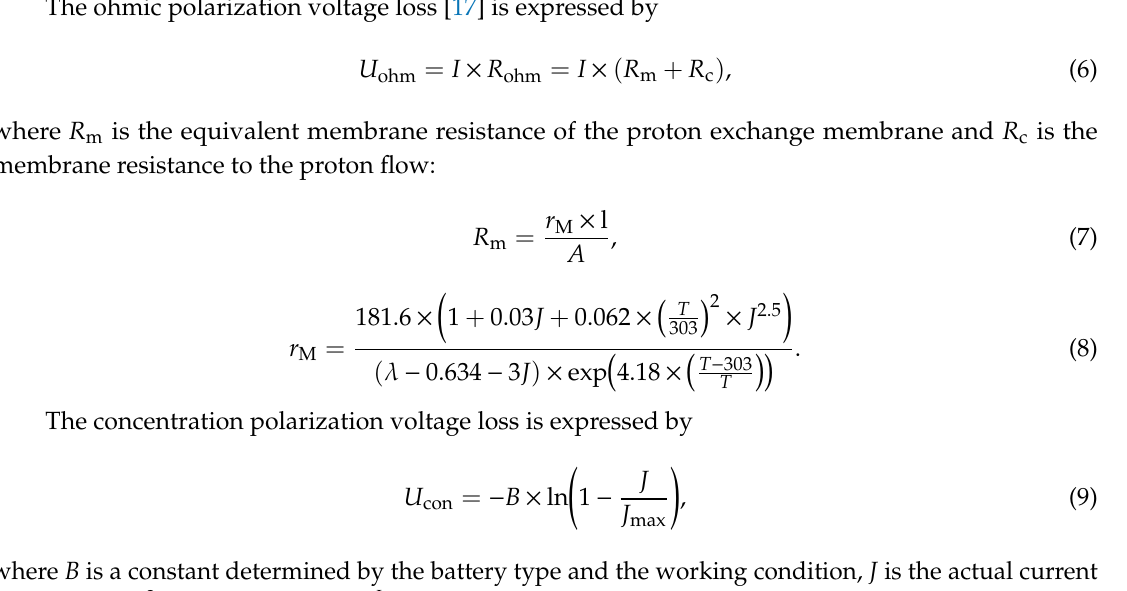
Table 1. Parameters of the fuel-cell model.